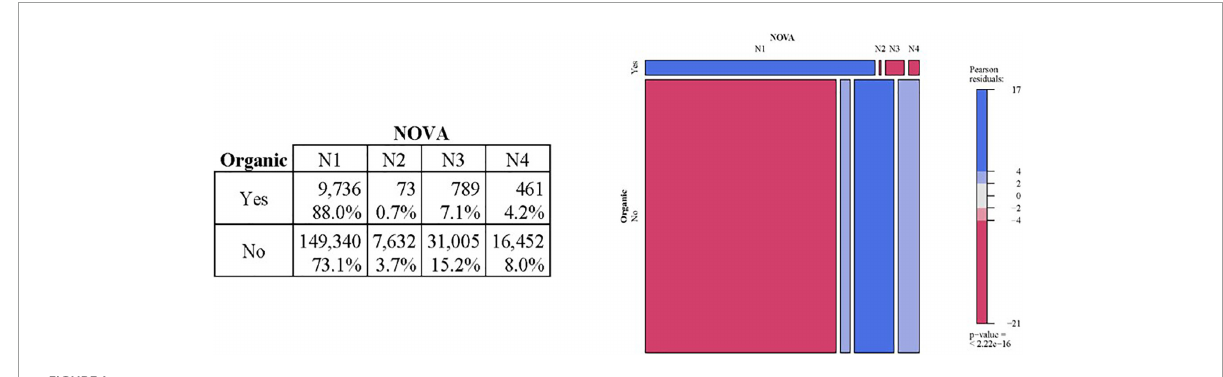
FIGURE1 Relationship between the consumption of organic food and NOVA.